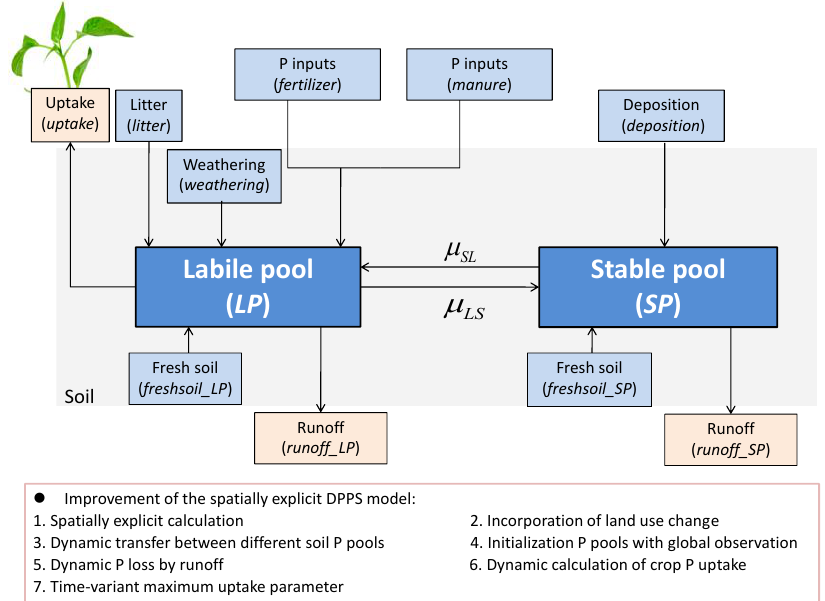
2. Incorporation of land use change